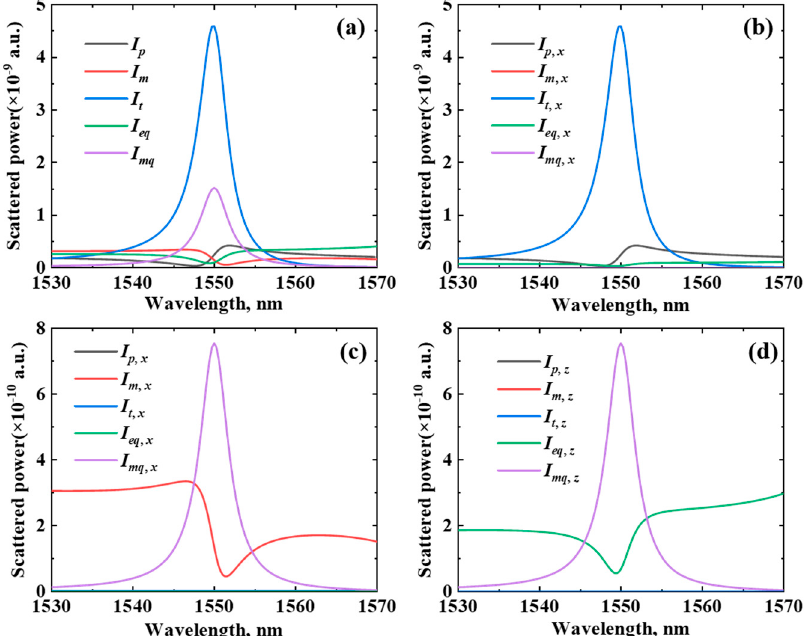
Figure 3. ( a ) Scattered powers from multipoles in terms of electric dipole ( p , black solid line), magnetic dipole ( m , red solid line), toroidal dipole ( t , blue solid line), electric quadruple ( eq , green solid line) and magnetic quadruple ( mq , purple solid line). ( b – d ) x , y and z component of scatter powers respectively.